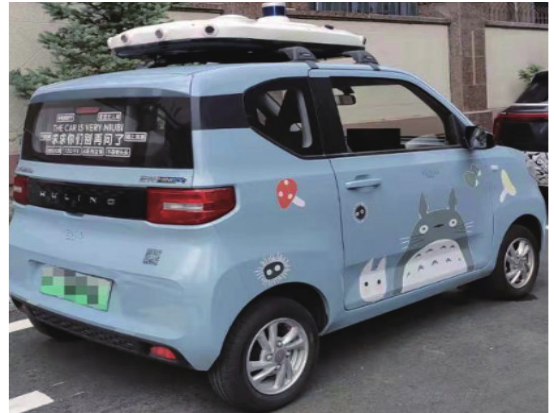
Figure 3. The experimental AV.